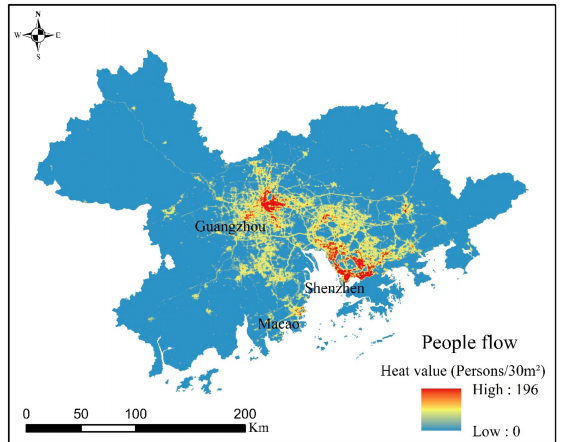
Figure 3. The heat map of Tencent Migration data in